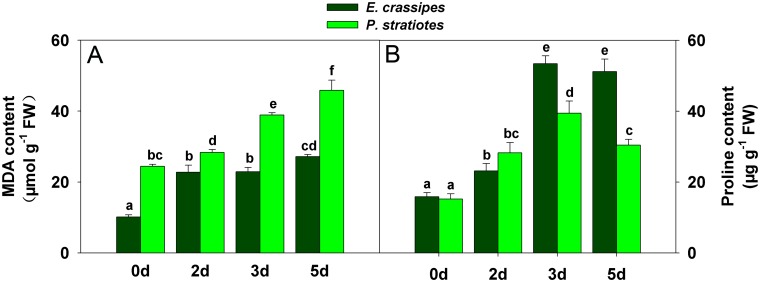
Changes in malondialdehyde (MDA) and proline content in E. crassipes and P. stratiotes exposed to 100 mg/L Cd for different times.A: MDA content change. B: Proline content change. Data are presented as mean ± standard error. Different letters following mean values indicate significant differences (Tukey’s test, P<0.05).